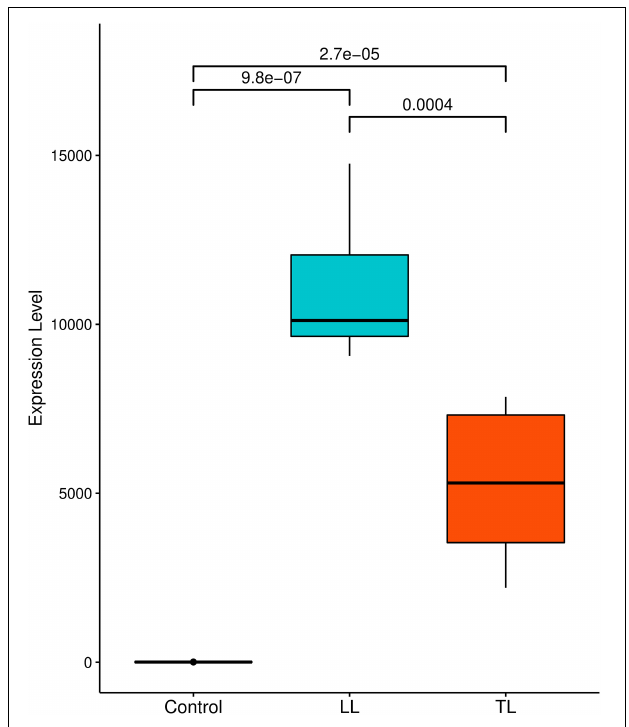
FIGURE 1 | Comparison of P2X7 expression level under different conditions: box plot represents median and interquartile range of FPKM expression level of each sample. A significance test was performed to indicate whether expression level between three samples differed significantly. X -axes show disease conditions (LL and TL) and control; Y -axes are FPKM values. FPKM, fragments per kilobase per million mapped reads.